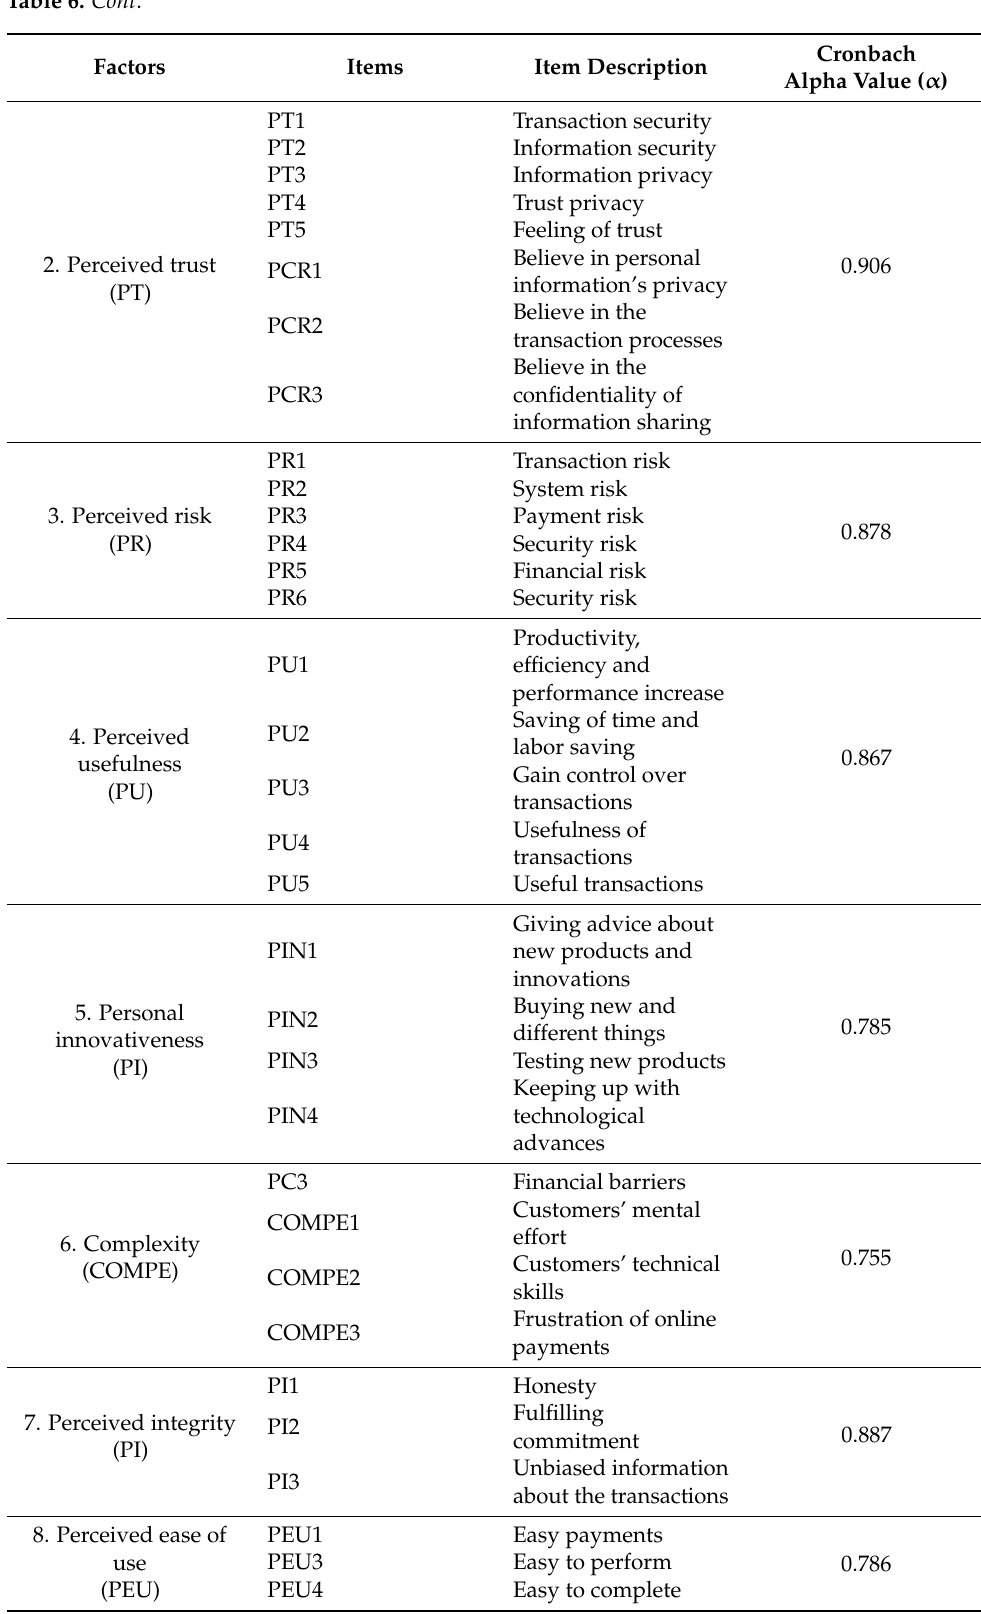
Table 6. Cont . Factors Items Item Description